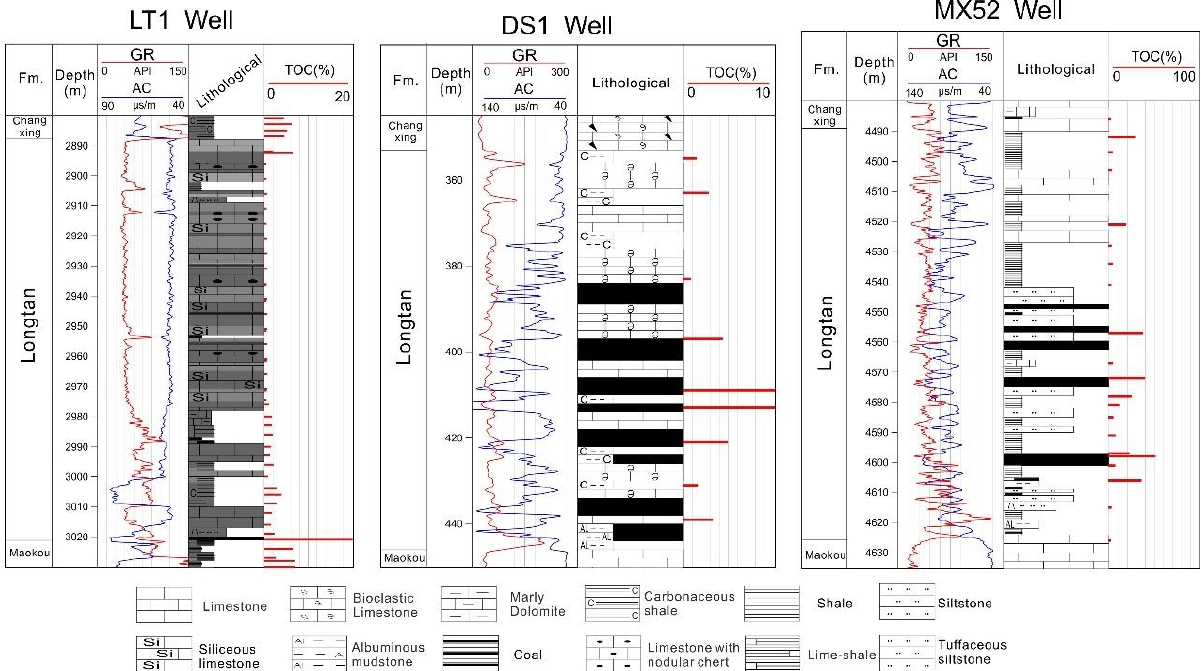
Figure 2. Lithological column and TOC of LT1 well, DS1 well and MX52 well.